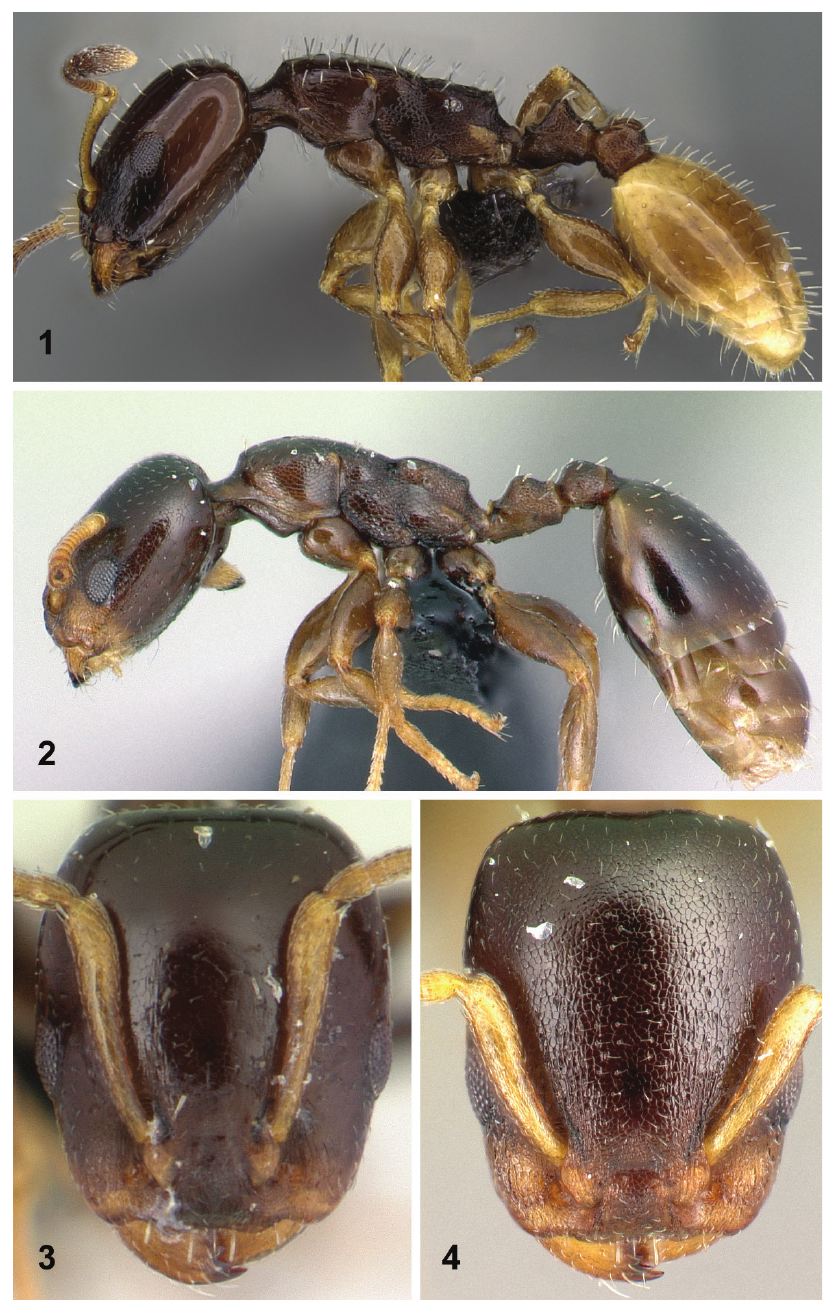
Figures 1–4. Diagnostic traits for black Nesomyrmex brevicornis -group workers. Lateral view of meso- soma, petiole, postpetiole, and gaster of N. flavigaster sp. n. ( 1 ), lateral view of mesosoma, petiole, post- petiole, and gaster of N. brunneus sp. n. ( 2 ), frontal view of head of N. edentatus sp. n. ( 3 ), frontal view of head of N. brevicornis sp. n. ( 4 ). For details see main